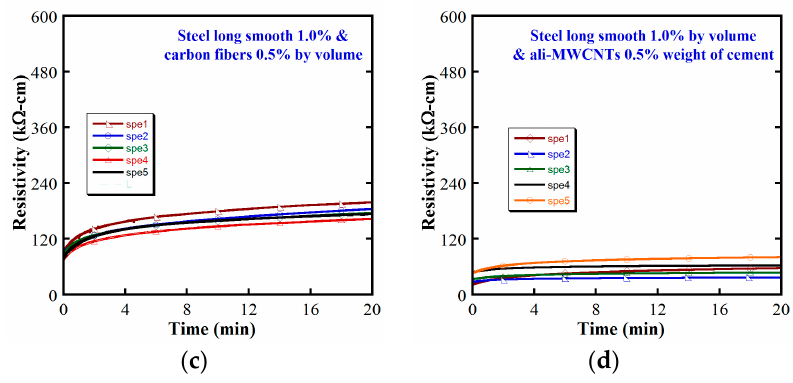
Figure 8. Electrical polarization responses of studied MSFRCs: ( a ) Plain mortar without fiber and powder; ( b ) 1.5 vol.% steel smooth fibers; ( c ) 1.0 vol.% steel smooth fibers & 0.5 vol.% carbon fibers;